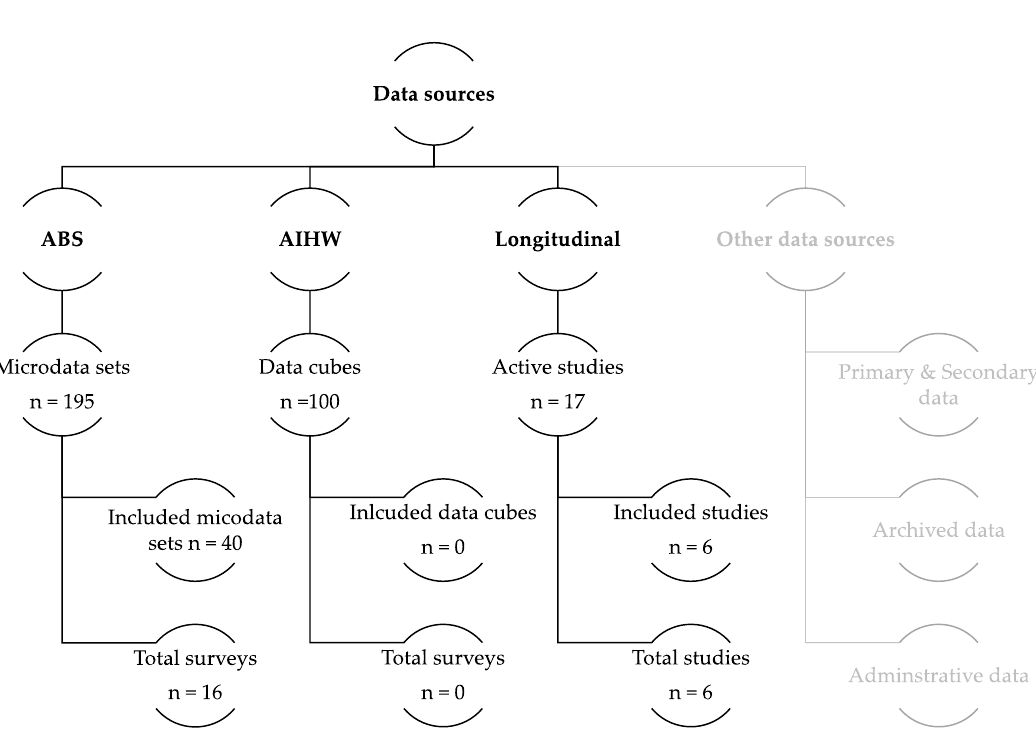
Figure 1. Summary of sources for identification of relevant data potentially reporting on the wellbeing of young adults living in Australia (ABS, Australian Bureau of Statistics; AIHW, Australian Institute of Health and Welfare).